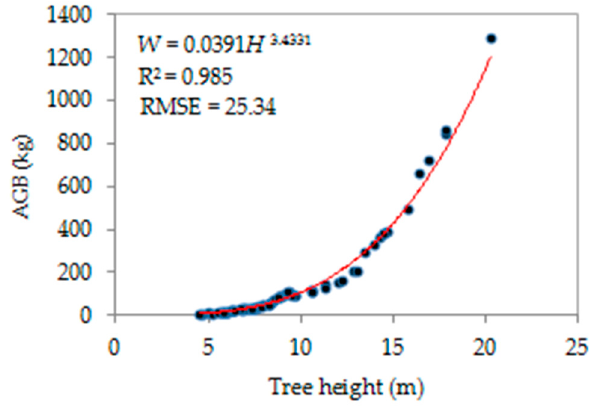
Figure 12. The fitting curve of the AGB on tree height (H).